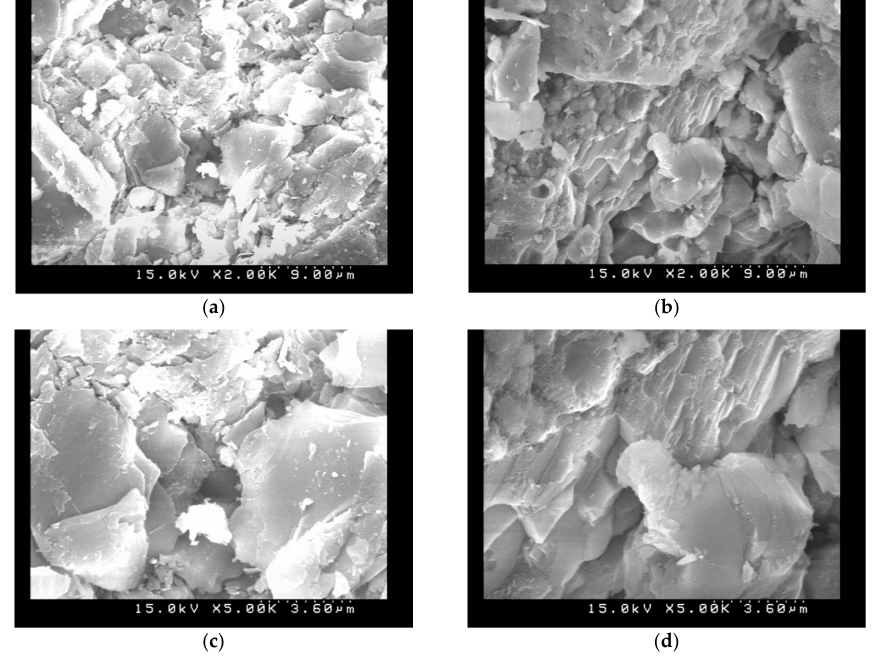
Figure 8. SEM images (S/A = 0.2, L/B = 0.5, P/A = 0.435): ( a ) without carbonation (2000×); ( b ) with carbonation (2000×); ( c ) without carbonation (5000×); and ( d ) with carbonation (5000×).